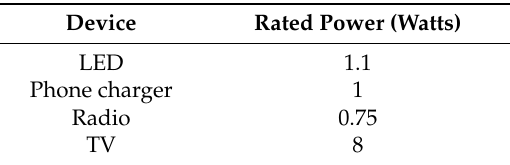
Table 2. Typical appliances’ specifications.